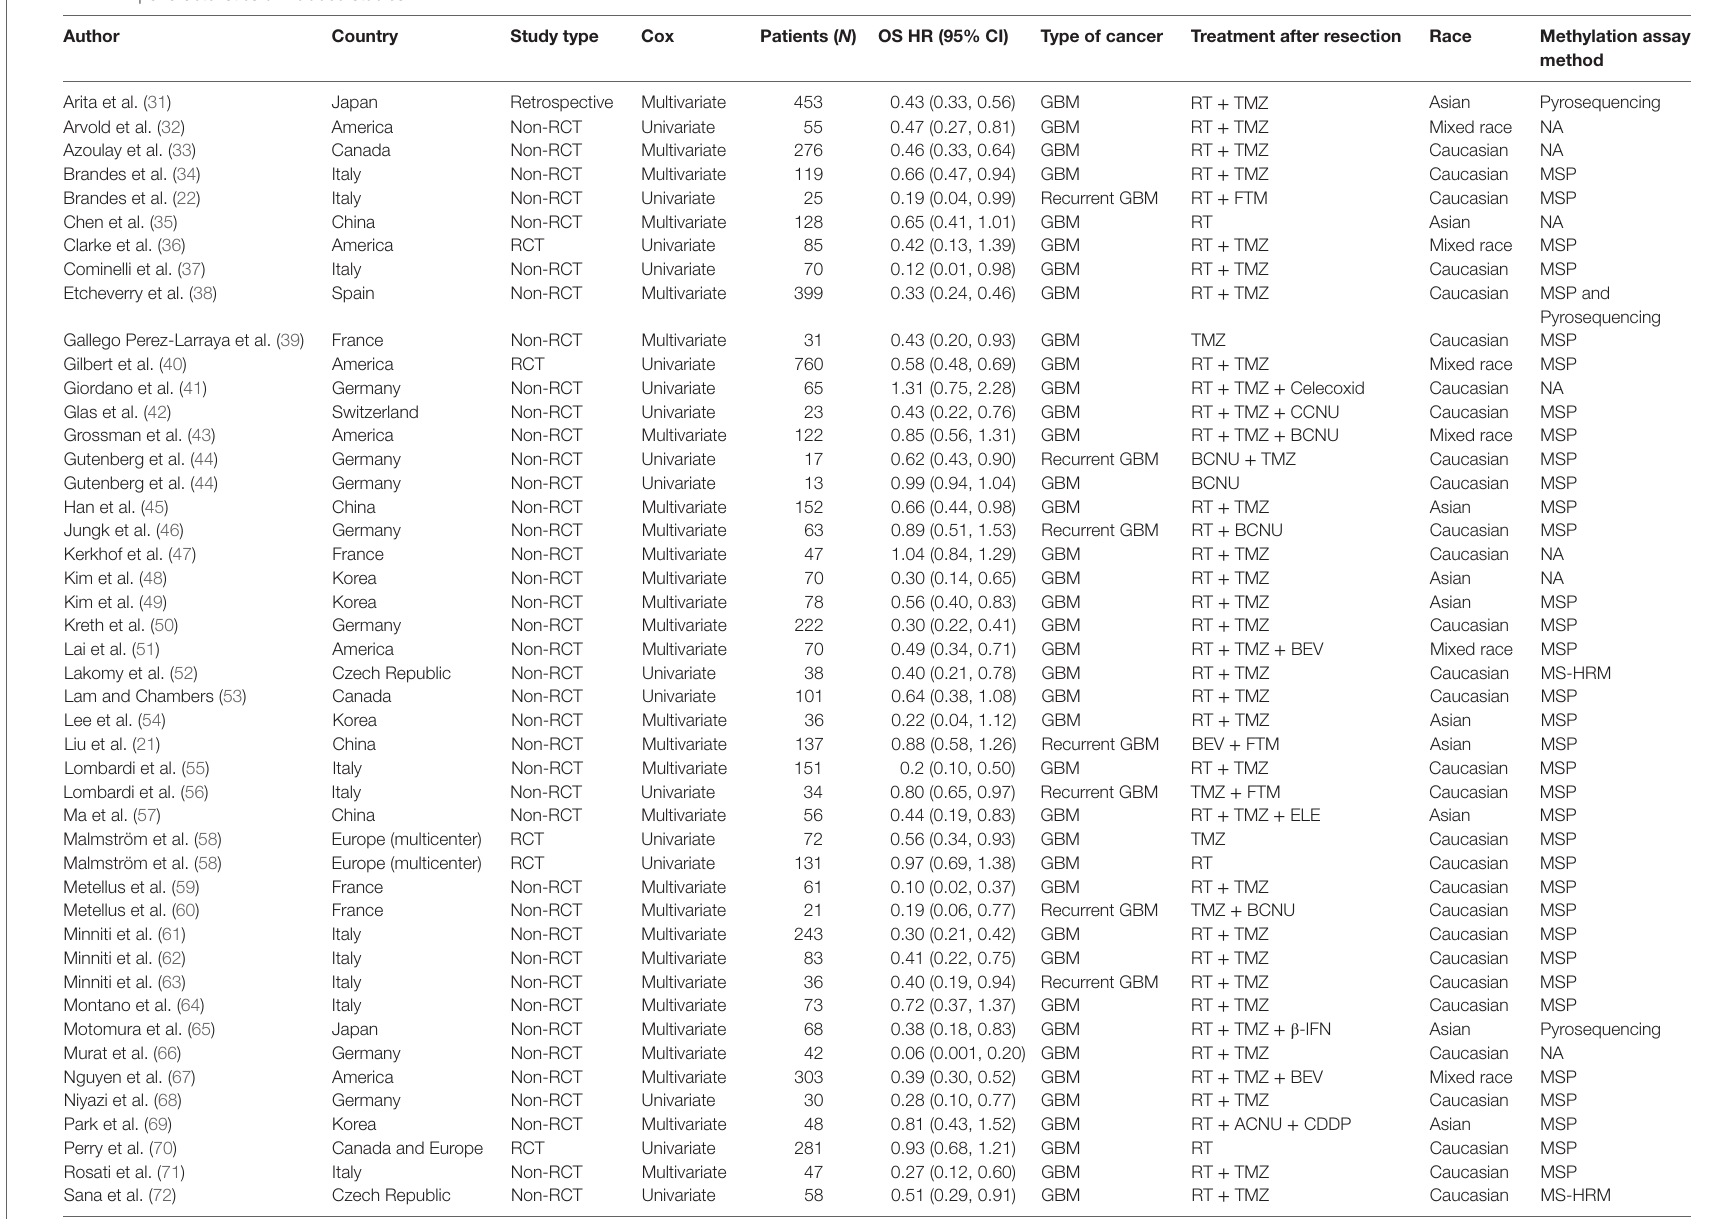
taBLe 1 | Characteristics of included